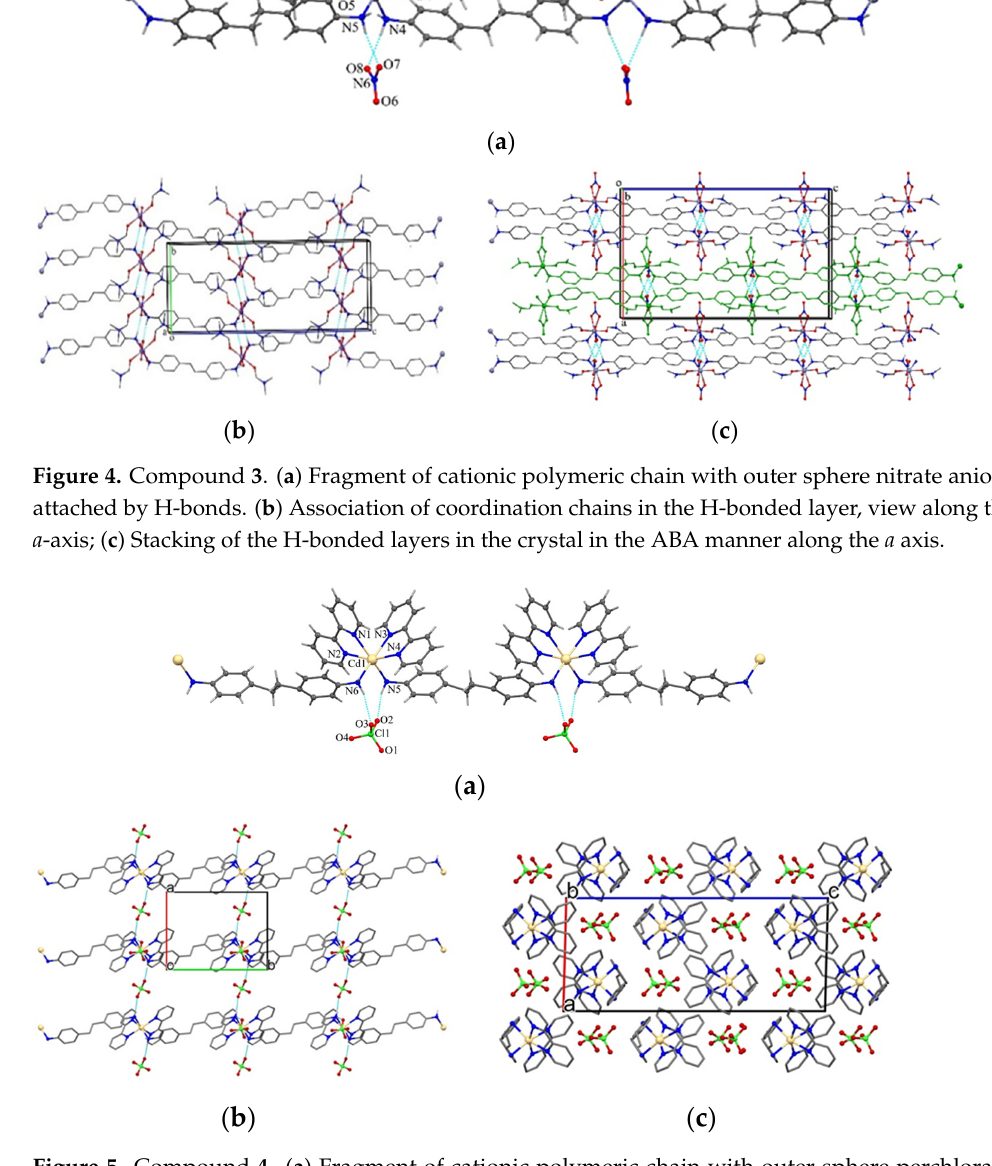
Figure 5. Compound 4 . ( a ) Fragment of cationic polymeric chain with outer-sphere perchlorate-anions attached by H-bonds. ( b ) Association of coordination chains in the H-bonded layer, view along the b -axis; ( c ) Crystal packing.